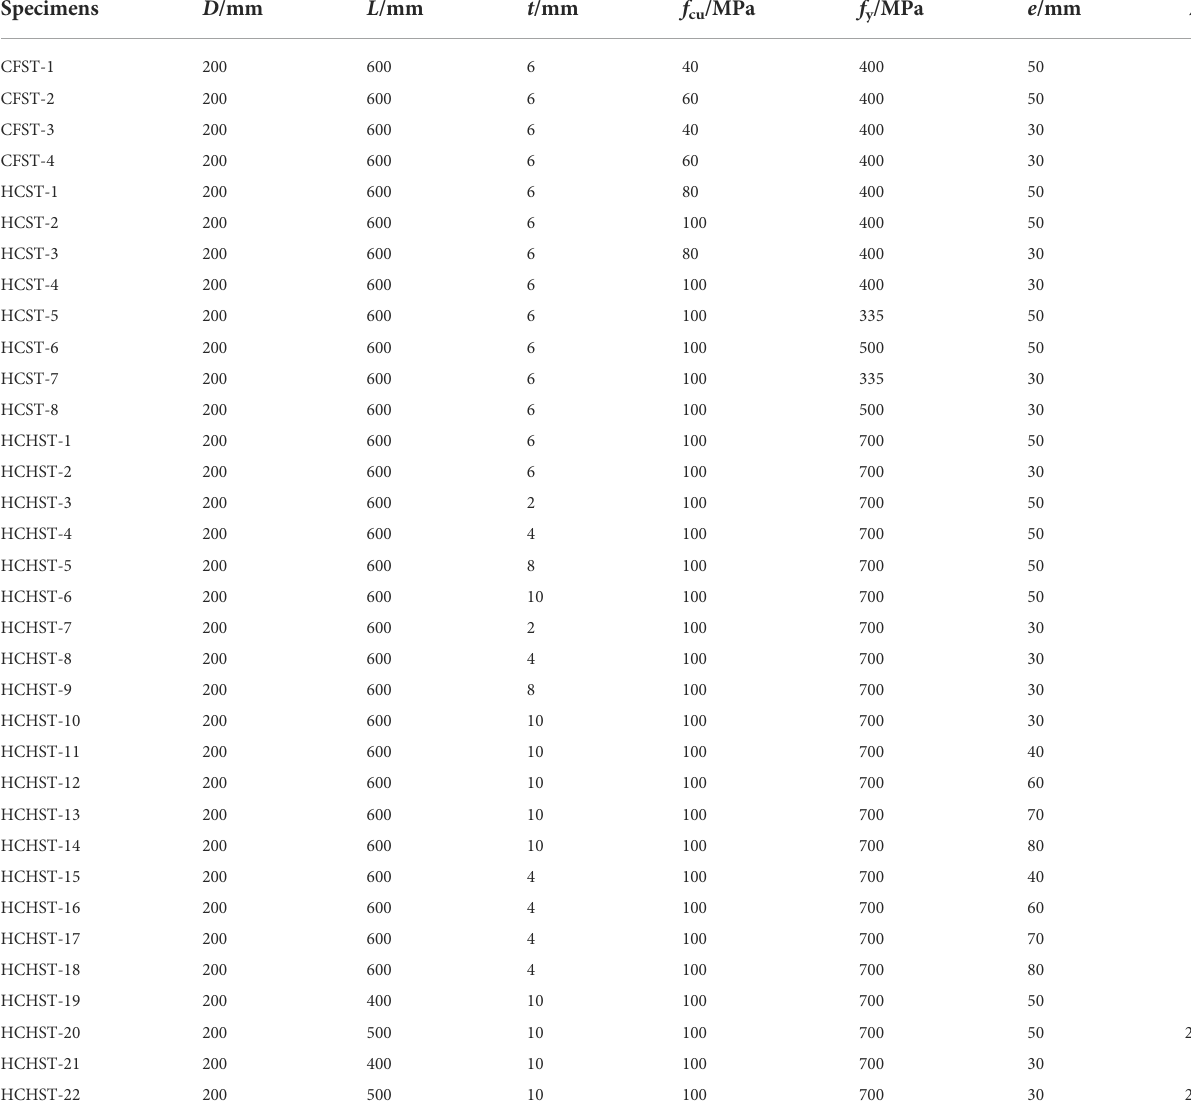
TABLE 1 Speci fi c parameters of 22 HCHST composite columns, 4 CFST composite columns and 8 HCST composite columns.